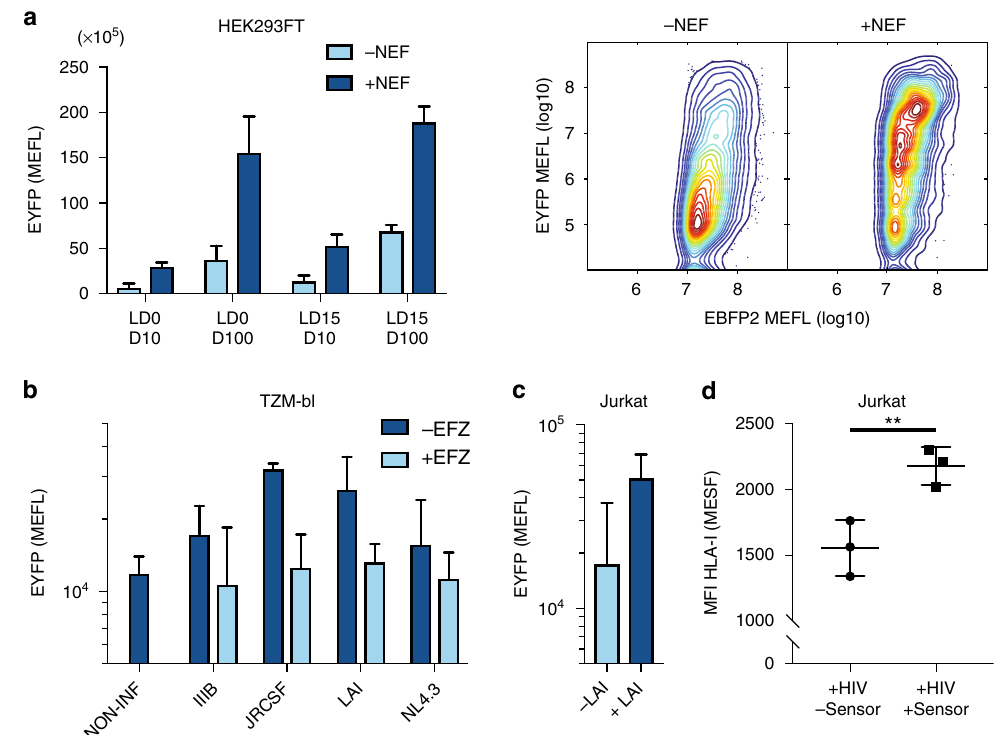
Fig. 2 Nef-based HIV sensor-actuator. a Flow cytometry analysis of Nef devices (sdAb19-LD0/15-TCS(L)-GAL4-VP16, TEVp-LD0-SH3) in HEK293 cells treated with 10nm or 100nM Dox (D10, D100) 48h post-transfection. Data show EYFP expression and standard deviation using molecules of equivalent fl uorescein (MEFL) of EYFP for cells expressing >1×10 7 MEFL of transfection marker Paci fi c-Blue. n = 2 independent technical replicates. Two-dimensional fl ow cytometry plots for the best variant (sdAb19-LD0/D10) are shown on the right. b Infection with HIV strains (IIIB, JRCSF, LAI, NL4.3) of TZM-bl cells expressing Nef device (sdAb19-LD0/D10). EYFP expression was compared to non-infected cells (NON-INF) and to cells infected and treated with the reverse transcriptase inhibitor Efavirenz (EFZ), showing that the device is sensitive to the inhibitory activity of the drug on viral genome retro-transcription. EYFP expression and standard deviation, using molecules of equivalent fl uorescein (MEFL) of EYFP for cells expressing 2×10 5 MEFL of transfection marker Paci fi c-Blue. n = 3 independent technical replicates. c Infection with HIV LAI strain of Jurkat cells expressing the Nef device (sdAb19-LD0/D10). EYFP expression and standard deviation using EYFP MEFL for cells expressing >1×10 5 MEFL of transfection marker Paci fi c-Blue. n = 2 independent technical replicates. d HLA-I surface expression in Jurkat cells infected with LAI strain in the presence or absence of Nef device (sdAb19-LD0/D10). Immunostaining was followed by fl ow-cytometry of infected cells (gated on intracellular p24 + cells) expressing ( + sensor) or not expressing ( − sensor) the device. MFI indicates Mean Fluorescence Intensity. Results are mean ±s.e.m. of three independent experiments. Statistical signi fi cance was determined by a paired t test ** p =